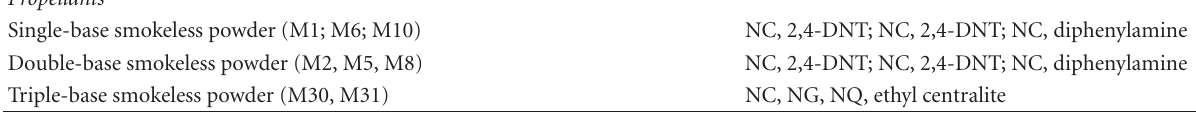
(Table 2). The octanol : water partitioning coe ffi cient of TNT (log K ow = 1.86) indicates that dissolved TNT will not